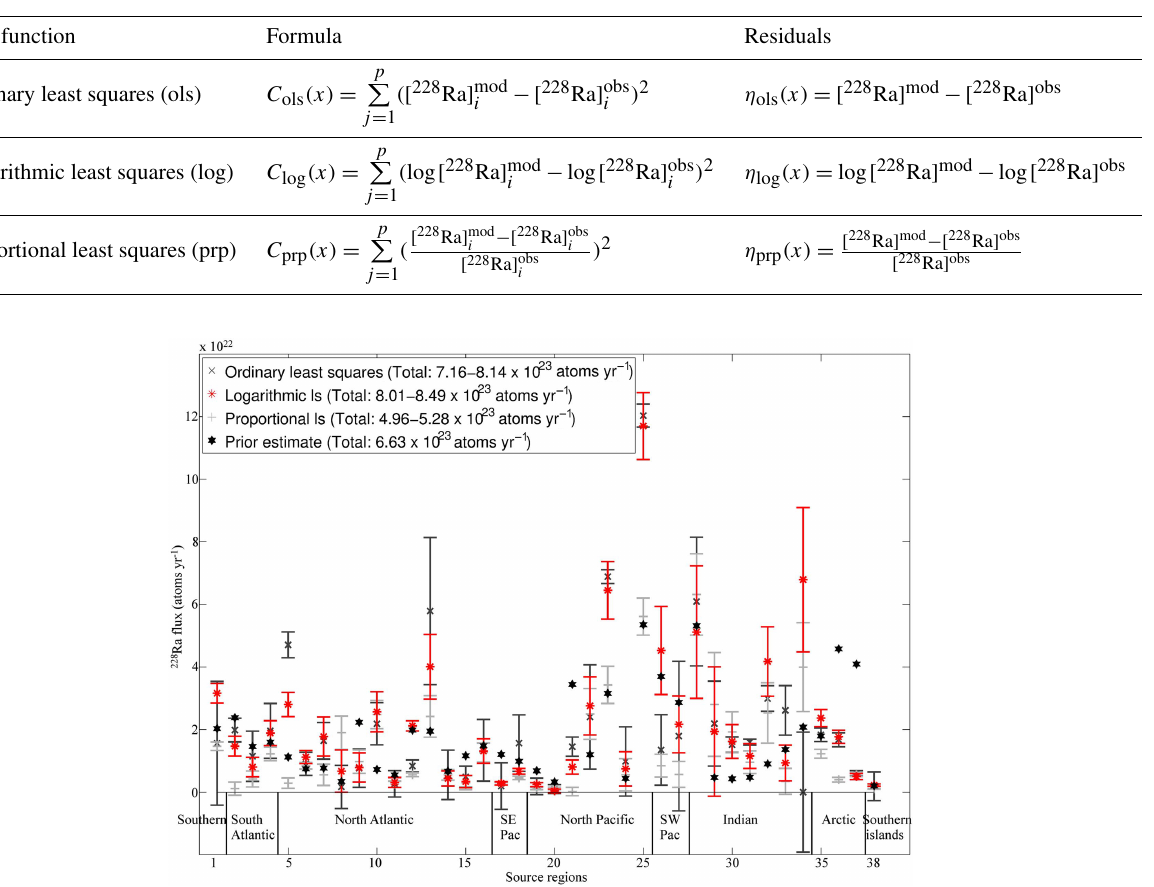
Table 1. Cost functions.